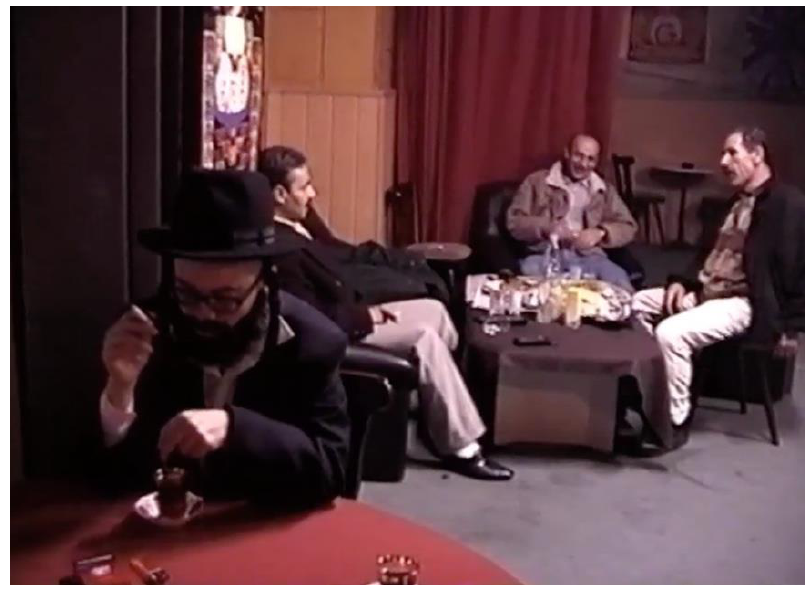
Figure 9. Oreet Ashery, Marcus Fisher’s Wake , 2000, 16:15. Video still, 10:58 min. Courtesy of the artist.